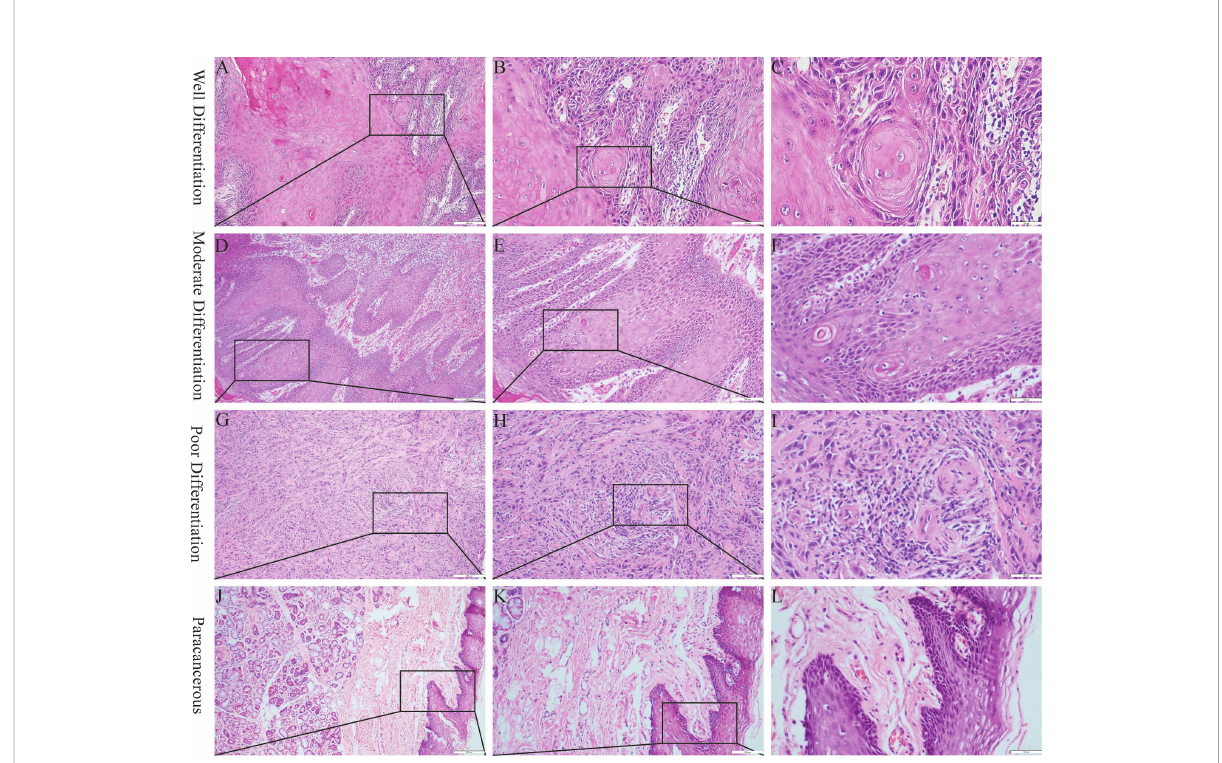
FIGURE 1 Hematoxylin and eosin staining of OSCC. (A – C) Well differentiation OSCC in 10×, 20×, 40×. (D – F) , Moderate differentiation OSCC in 10×, 20×, 40×. (G – I) Poor differentiation OSCC in 10×, 20×, 40×. (J – L) Paracancerous samples in 10×, 20×,